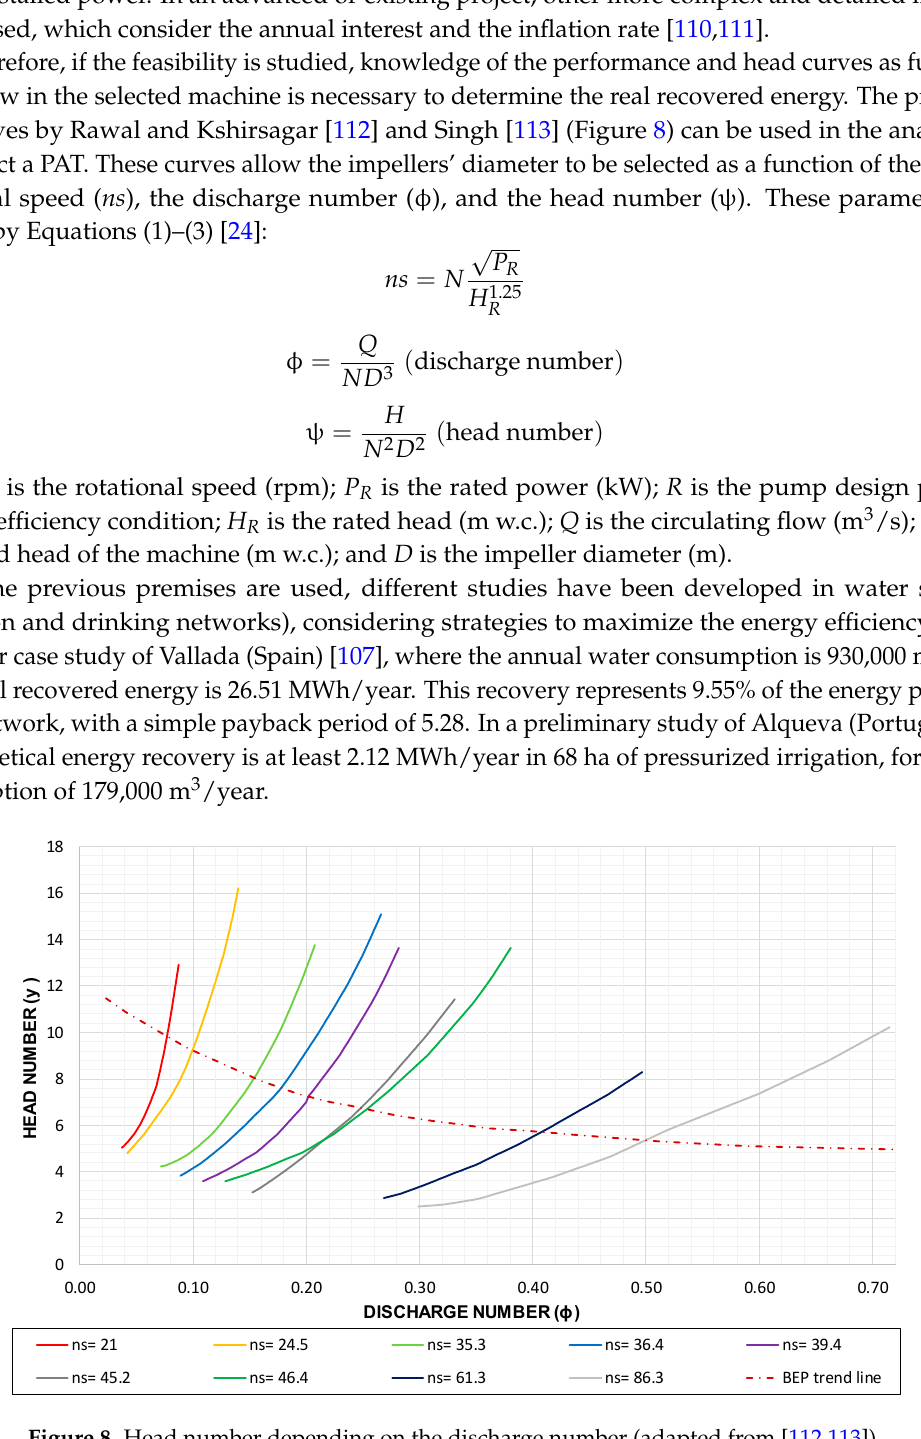
Figure 8. Head number depending on the discharge number (adapted from [112,113]).